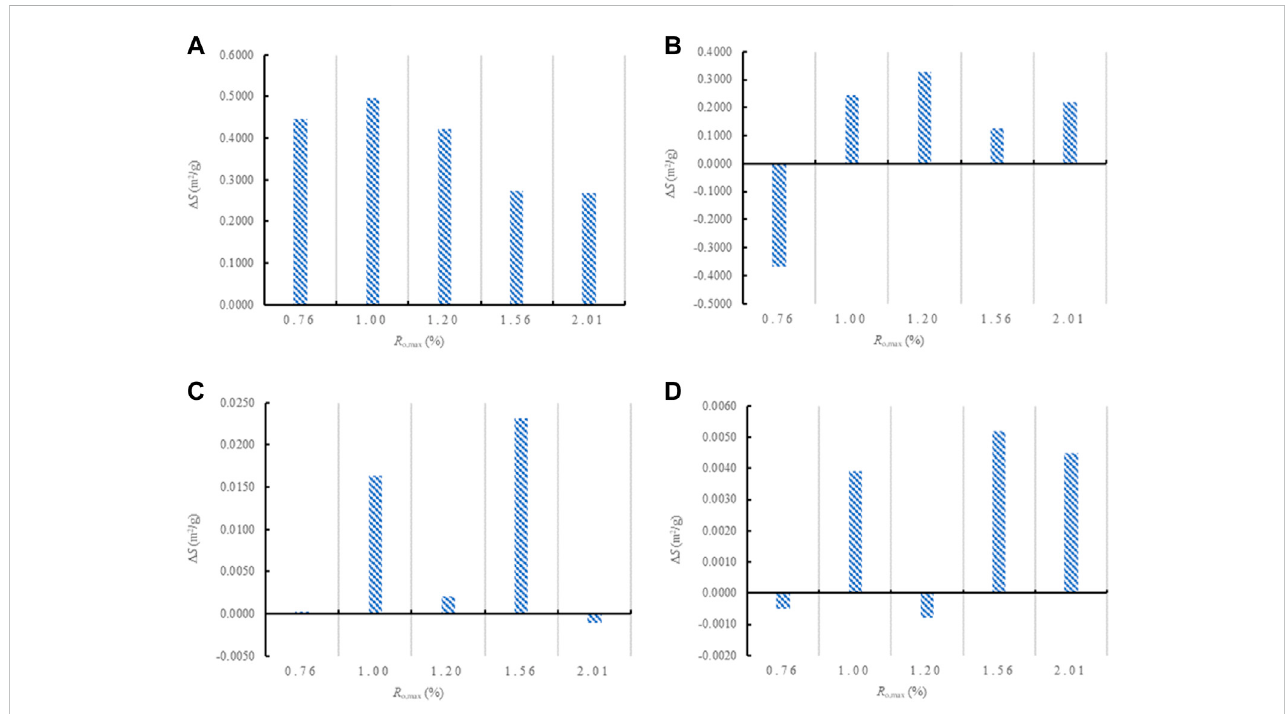
FIGURE 6 The changes of incremental pore-speci fi c surface area of coal due to Sc-CO 2 extraction (A) Micropore; (B) Transitional pore; (C) Mesopore; and (D)